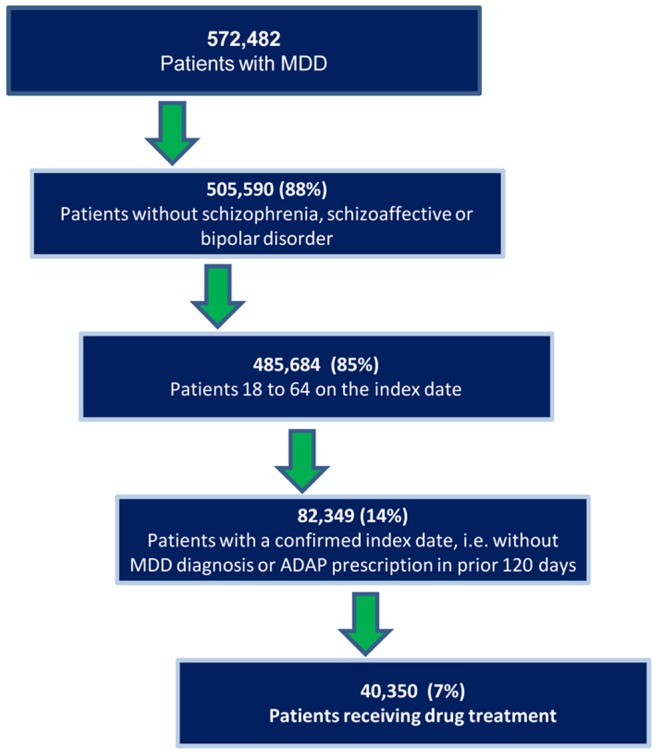
Patient selection flow.Cascade depicting patient selection after applying various filters, and the number of patients excluded at each filter.